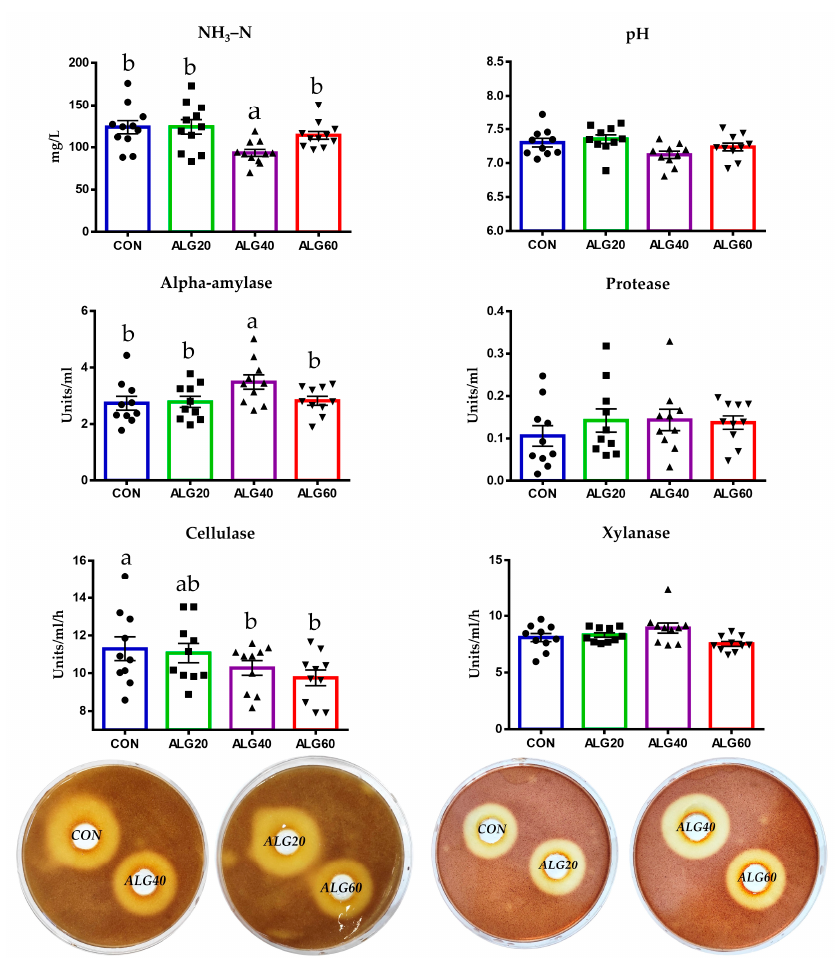
Figure 8. Effects of supplementing with microalgae Schizochytrium spp. on pH, ammonia concentration, alpha-amylase, protease, cellulase, and xylanase activity in the rumen fluid for the four dietary treatments (CON, ALG20, ALG40, and ALG60) within the two sampling times (20th and 40th days) illustrated in bar graphs ± SEM. Alpha-amylase and protease were determined spectrophotometrically, while cellulase and xylanase activities were assayed (individually) using Petri dishes. Petri dishes depict the area of the zone of clearing of the pooled rumen fluid of each dietary treatment which runs as a preliminary trial prior to the individual ones. Bars with different superscripts (a, b) between dietary treatments differ significantly ( p ≤ 0.05) according to the analysis of variance (ANOVA) using a general linear model for repeated measures and post hoc analysis was performed when appropriate using the Tukey’s multiple range test. CON = control concentrate without microalgae ( Schizochytrium spp.); ALG20 = CON with 20 g/Kg Schizochytrium spp.; ALG40 = CON with 40 g/Kg Schizochytrium spp.; ALG60 = CON with 60 g/Kg Schizochytrium